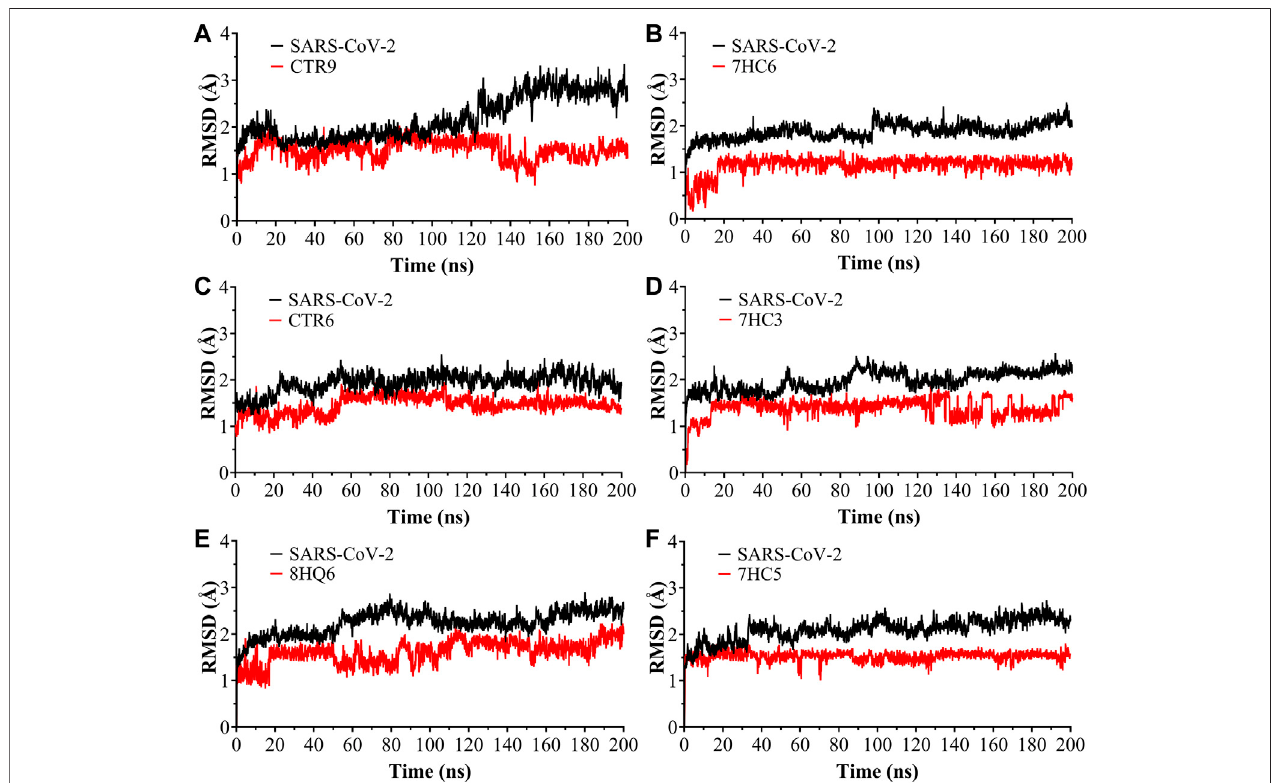
FIGURE3| Root MeanSquareDeviation(RMSD) asafunction ofsimulatedtimes forthecomplexesformed betweenSARS-CoV-2M pro and (A) CTR9, (B) 7HC6, (C) CTR6, (D) 7HC3, (E) 8HQ6 and (F) 7HC5 molecules.